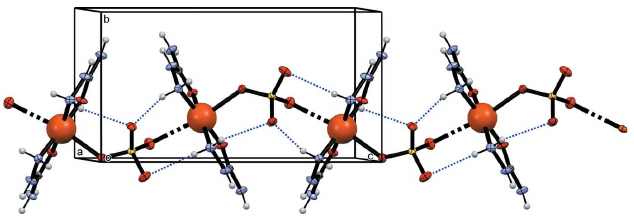
Figure 2 The formation of polymeric chains. Intramolecular hydrogen bonds are indicated by dotted lines.